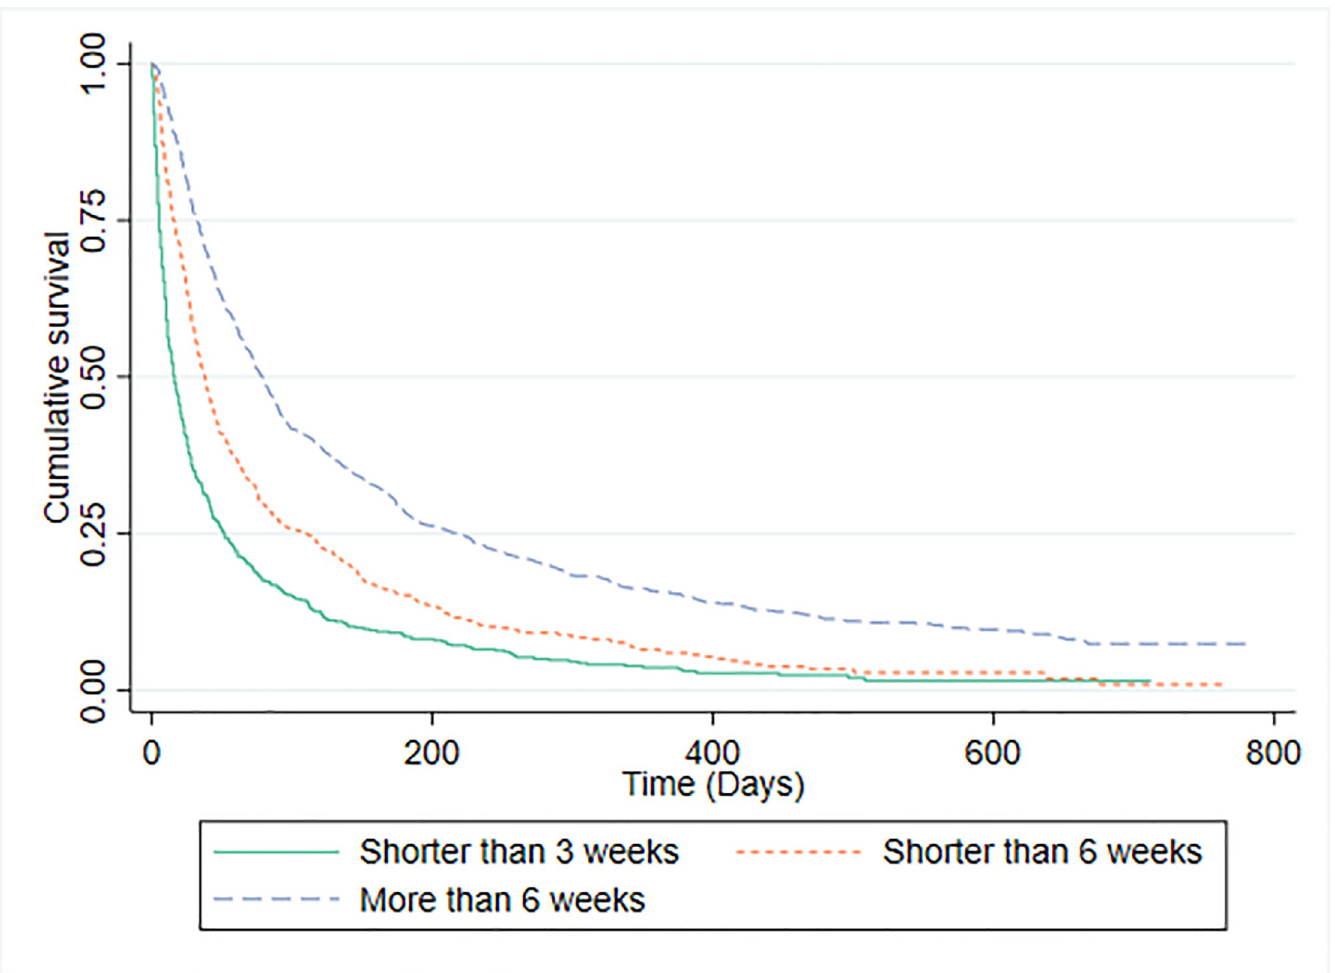
Fig 5. Kaplan-Meier survival curves for PPI predictions.